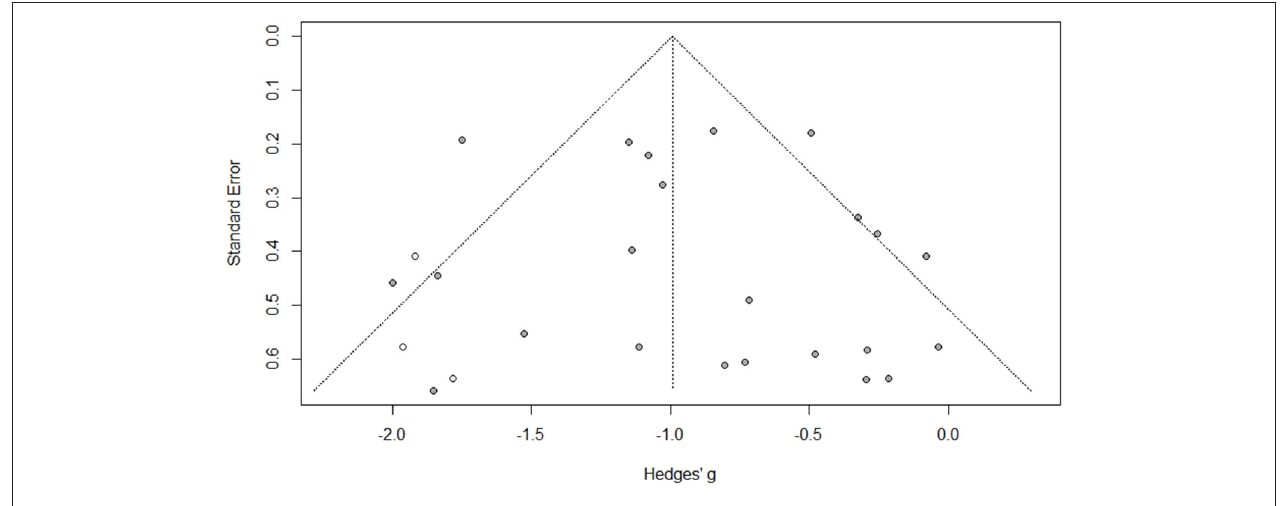
FIGURE 9 | Publication bias assessment of the long term studies used for fasting blood glucose level as an effect of consuming millet-based meal (after applying trim and fill method) ( p <